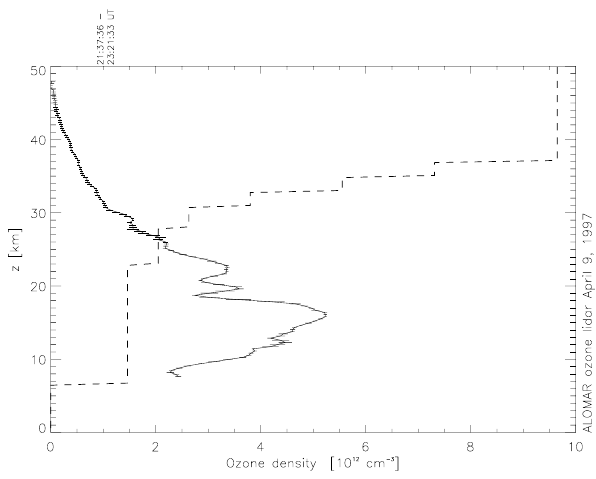
Fig. 1. Ozone profile measured with the ALOMAR ozone lidar on 9 April 1997, 21:37–23:21UT. Uncertainties derived from the slope fit procedure (see text) are marked as horizontal bars. Dashed line: altitude range used for the slope fit, e.g. 1.5km (5 vertical range gates) in the altitude range